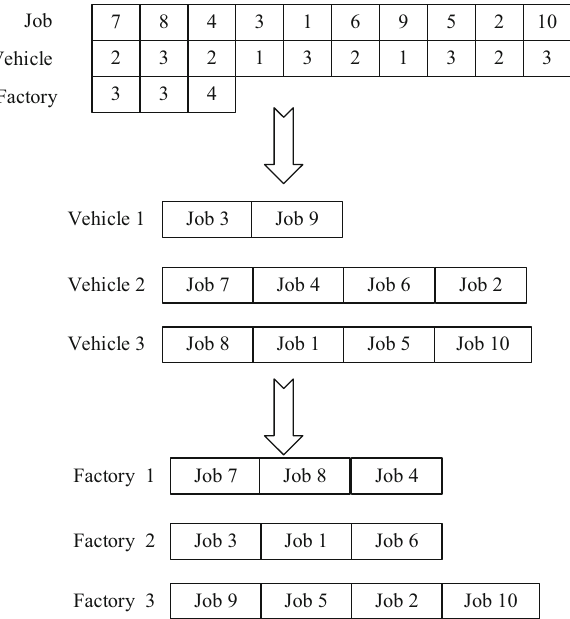
Fig. 3 A chromosome of GA-2HMS&TS